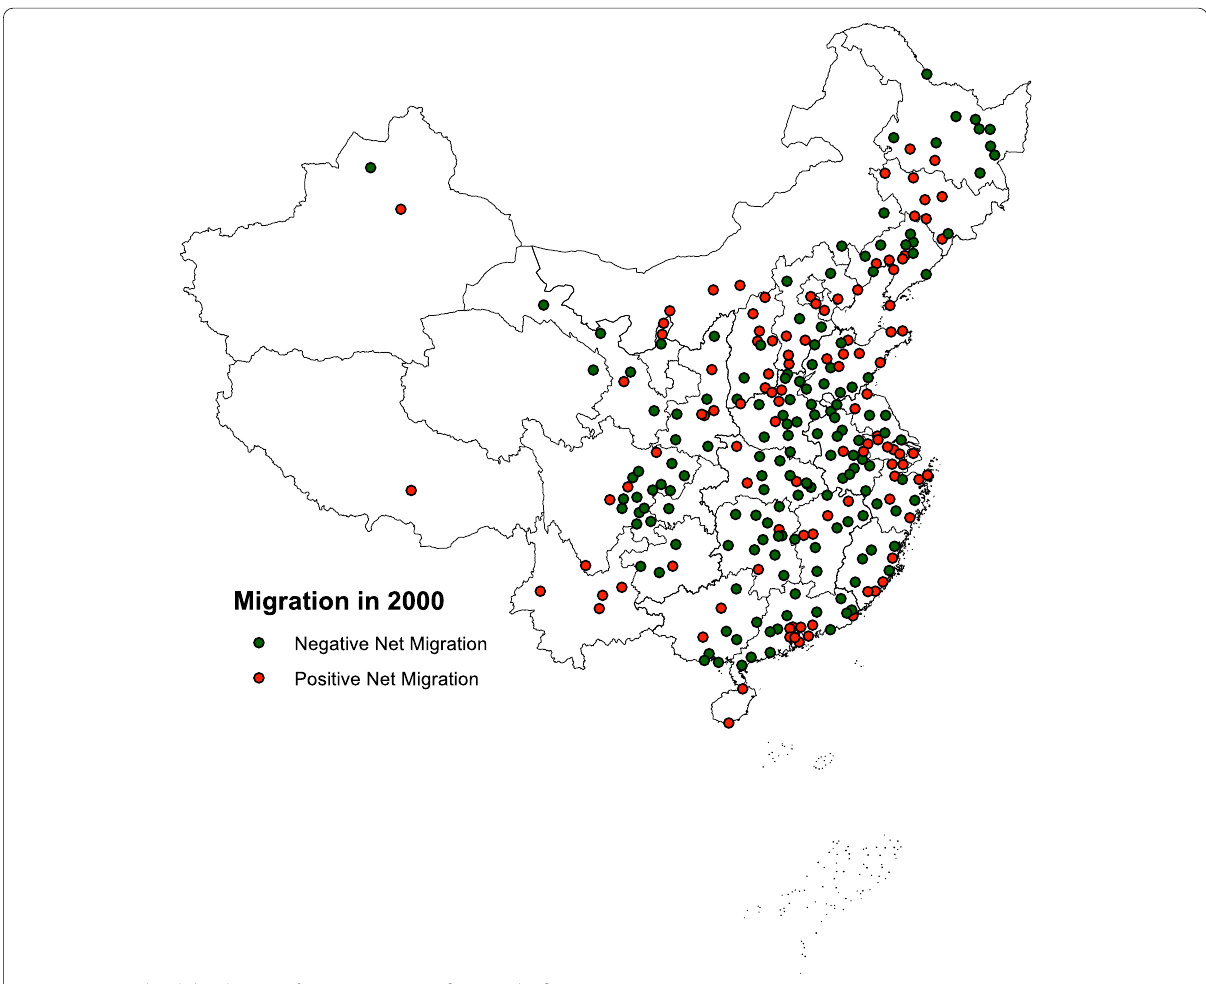
Fig. 2 Geographical distribution of migration net outflows and inflows in